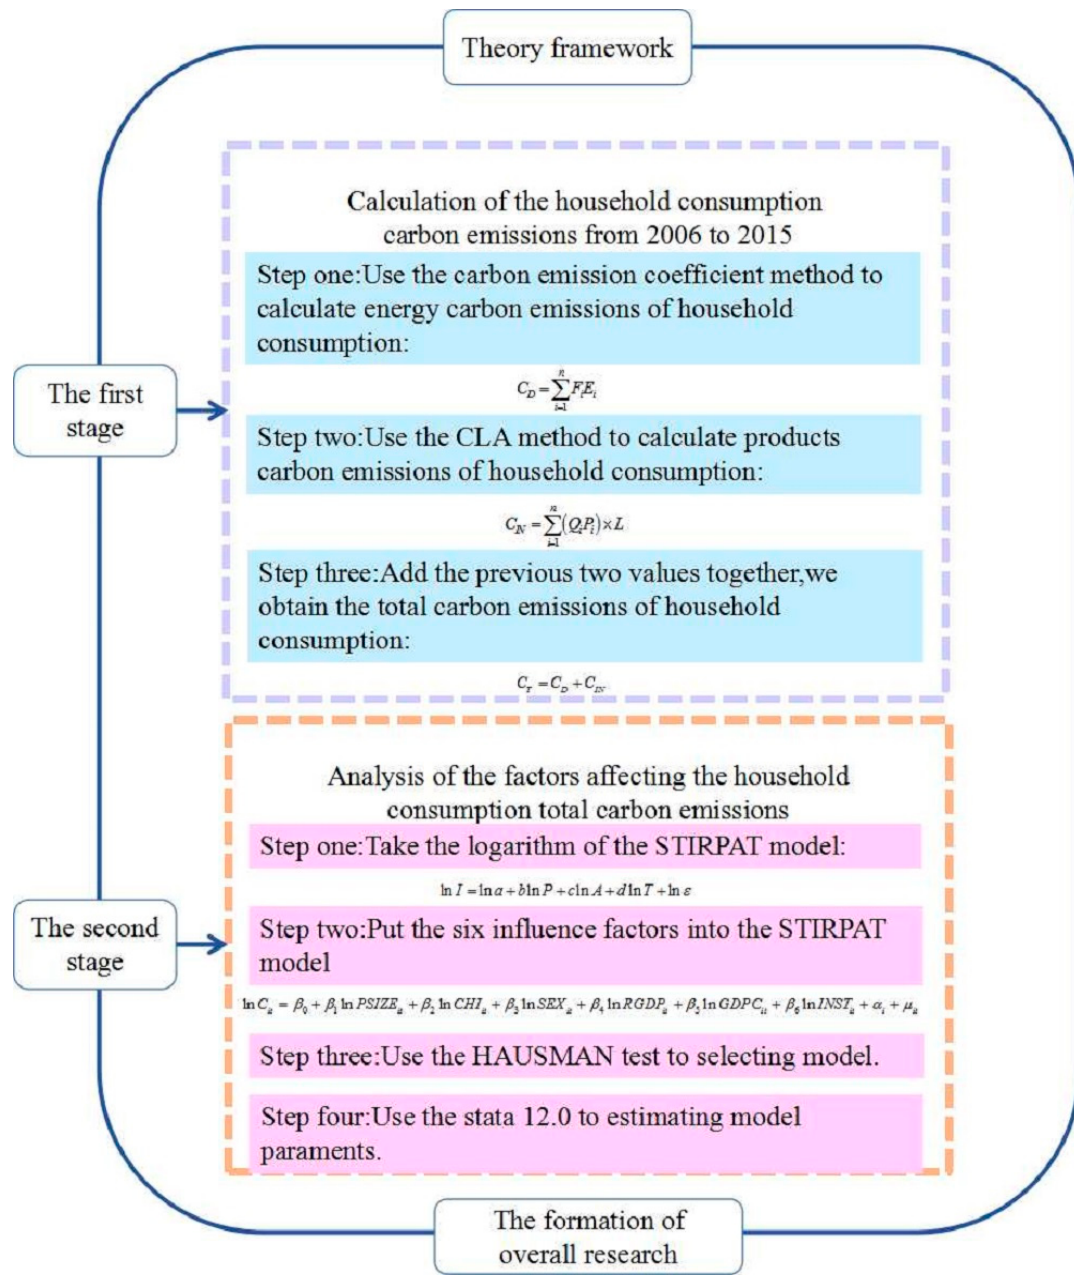
Figure 1. Method flowchart.